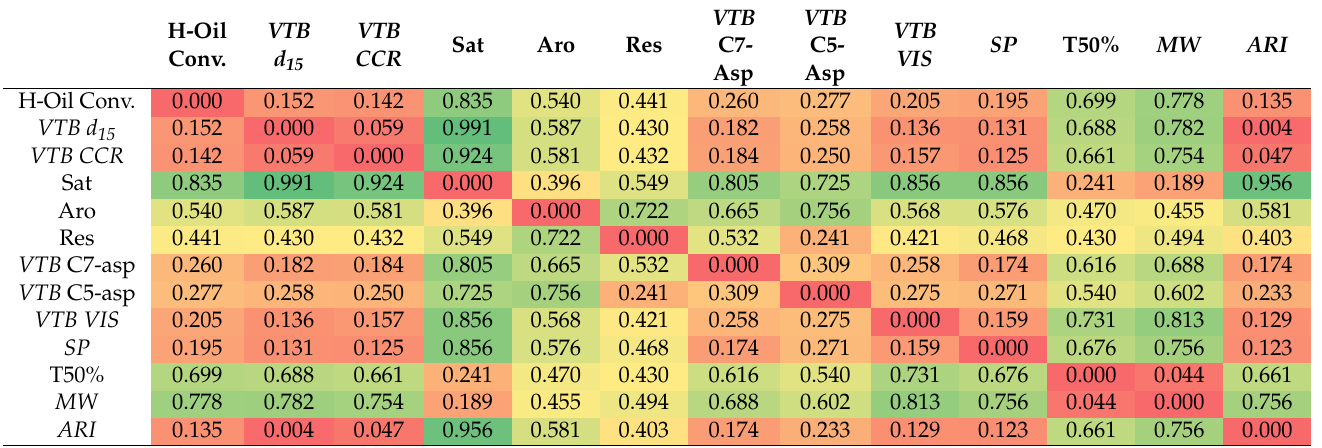
Table 8. The υ -values for the ICrA evaluation of relations between properties of the studied H-Oil VTB s.